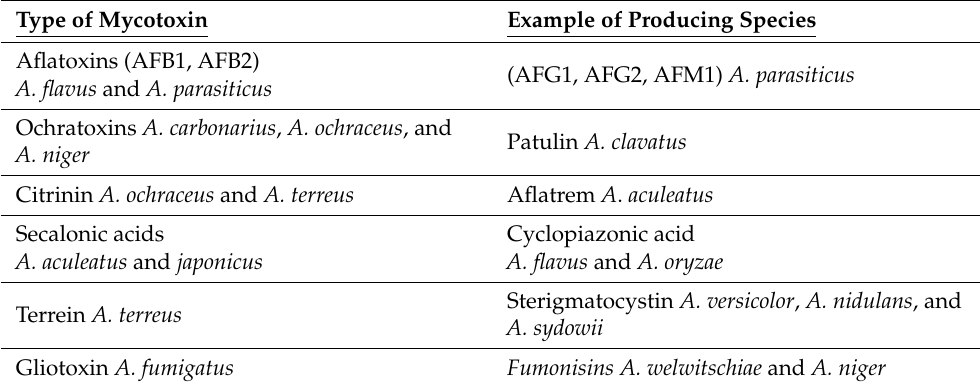
Table 2. Major biotoxins produced by Aspergillus